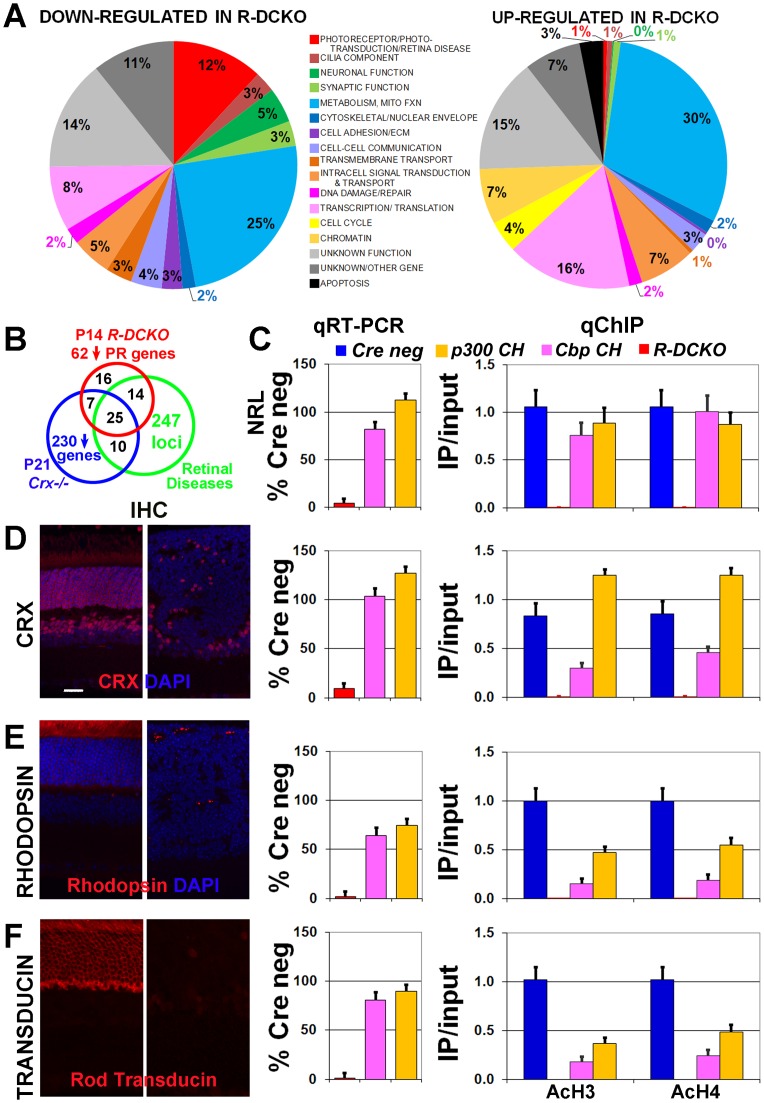
Expression of photoreceptor genes is decreased in R-DCKO retinas.
A. Summarized microarray findings for R-DCKO vs. Cre neg retinas. Each gene was categorized by the cell process in which it functioned, and results for each category are represented as a percentage of all the down- or up-regulated genes (see Supplemental Tables 2 & 3 for details). B. Schematic distribution of the 62 down-regulated photoreceptor or phototransduction-related genes in R-DCKO microarrays (red), compared with the 247 retinal disease loci listed in RetNet (https://sph.uth.edu/RetNet/home.htm; green) and a list of 230 genes down-regulated in Crx−/− retinas compiled from published sources [51]–[53]. Numbers in overlapping areas indicate the numbers of genes affected in both/all three conditions. All overlapping genes are listed in Supplementary Tables S4 and S5. C–F. Expression of the indicated rod gene (C.
Nrl
; D.
Crx;
 E.
Rhodopsin (Rho);
 F.
Rod Transducin (Gnat1)) was assessed by quantitative RT-PCR (qRT-PCR) at P14, and is expressed as percent of the level of Cre-negative littermate controls (% Cre neg). Protein localization was verified by immunohistochemistry (IHC) at P30. Scale bar  = 20 µm for all images. Levels of acetylated histone H3 (AcH3) or H4 (AcH4) on the respective promoter was determined by quantitative chromatin immunoprecipitation (qChIP) at P14, and is expressed as the value from the immunoprecipitated sample divided by the value from the untreated “input” sample, multiplied by 100 (“IP/input”).